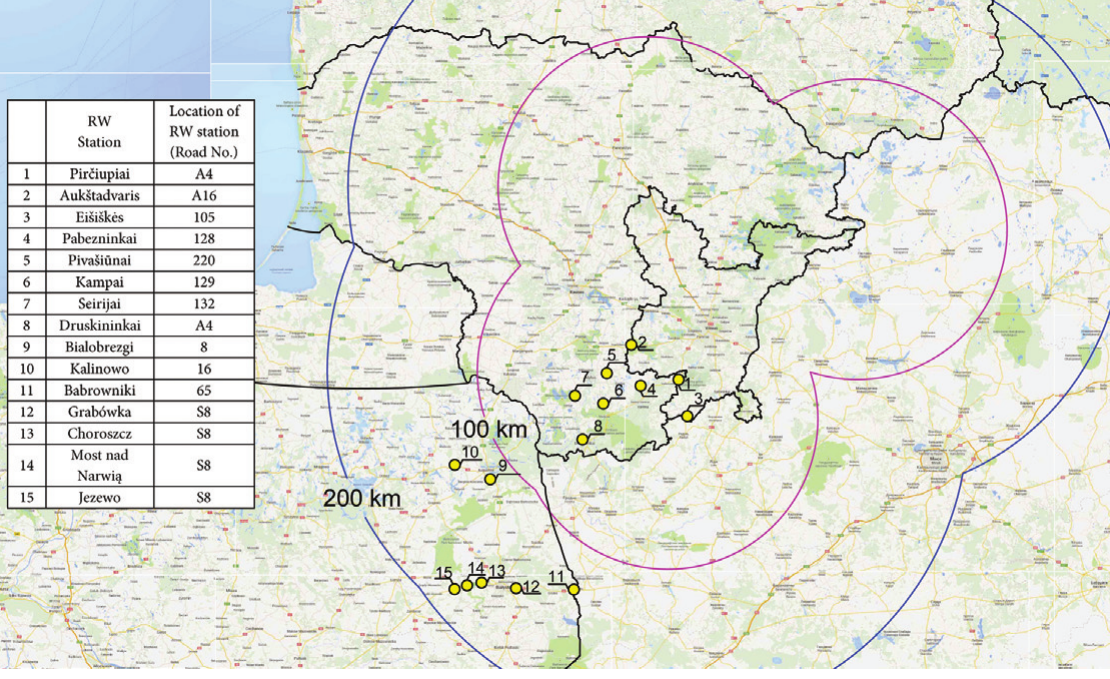
Fig. 3. The study road weather stations